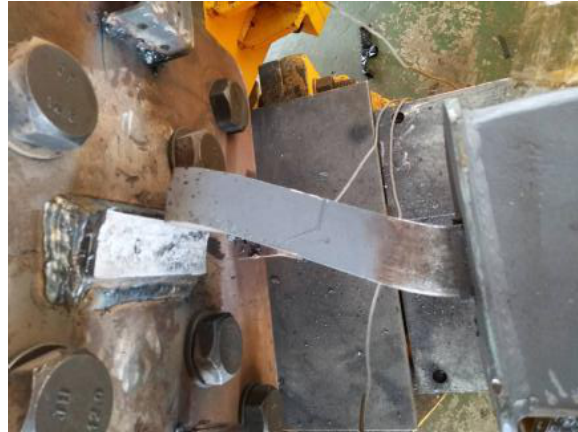
Figure 2. LPBRB specimen’s dimensions.